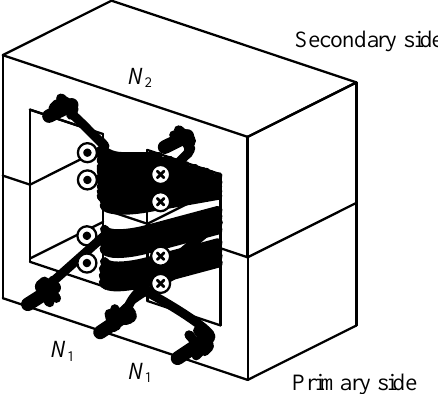
Figure 5. The winding structure for the large leakage inductance.